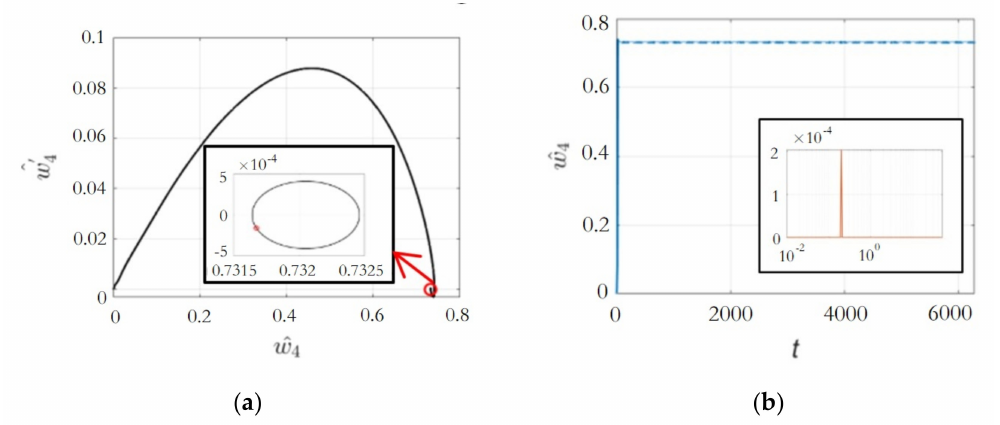
Figure 18. Periodical analysis of horizontal rotation: ( a ) Poincar é phase diagram; ( b ) time